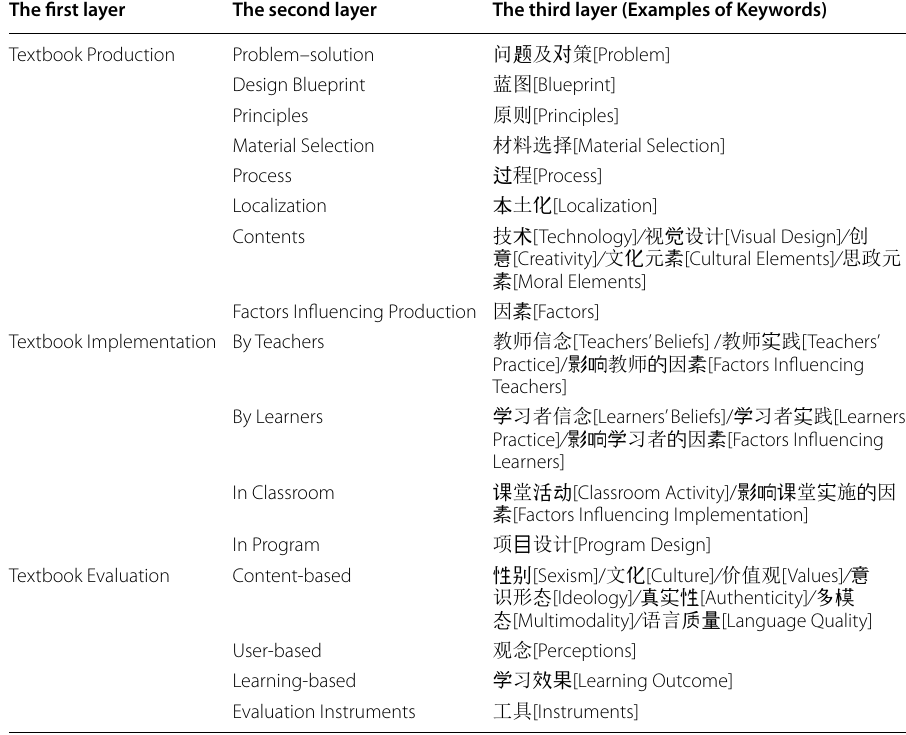
Table 1 The sub-scheme of coding research areas The first layer The second layer The third layer (Examples of Keywords) Textbook